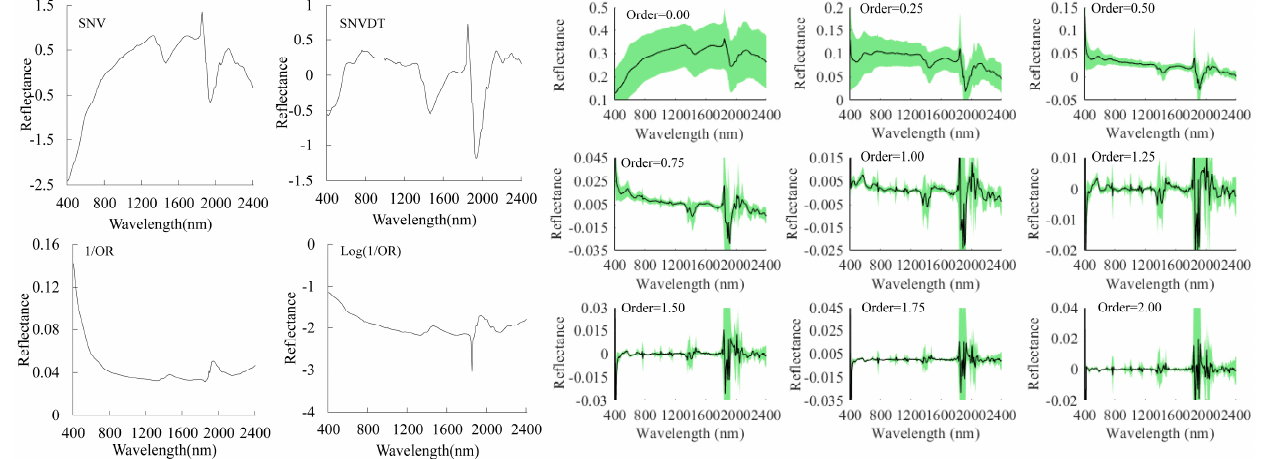
Figure 3. Pre-processing of mean spectral curves including standard normal variate (SNV), standard normal variate and detrend (SNV-DT), inverse (1/OR) (OR is original spectrum), inverse-log (Log(1/OR) and fractional order derivative (FOD) (range 0–2, with intervals of 0.25) (green areas represent the standard deviations of the spectra) collected from soil measured on the ground.